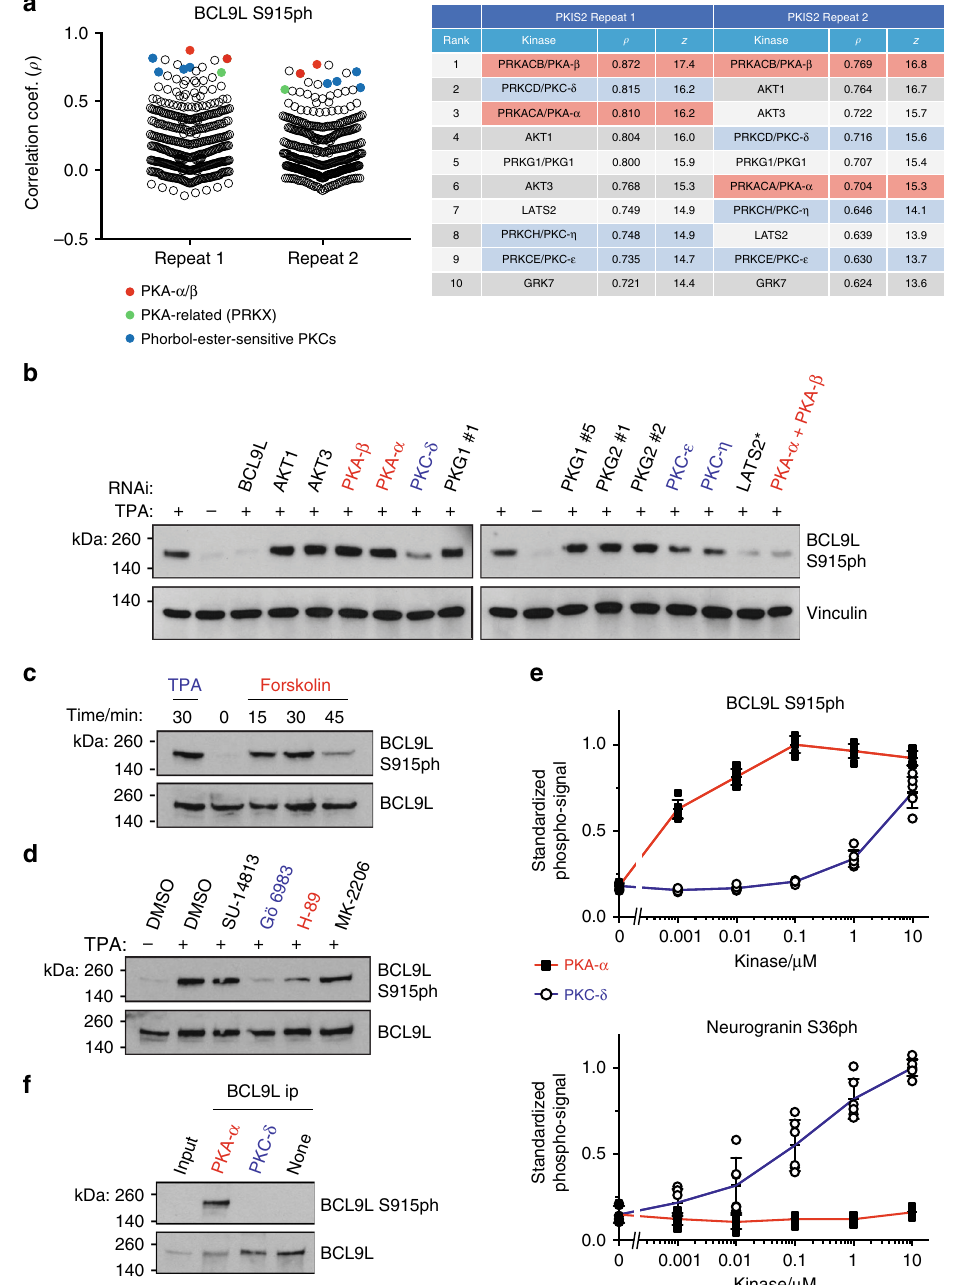
Fig. 6 Results of KiPIK screens for BCL9L S915ph and con fi rmatory experiments. a The stripcharts on the left show the Pearson correlation coef fi cients with each kinase in the PKIS2 DiscoverX pro fi ling dataset, for repeats 1 and 2. The table on the right shows the top 10 hits with corresponding correlation coef fi cients and z -scores. The overall top hit kinase (PKA) is shown in red, and the closely related kinase PRKX in green. Phorbol-ester-responsive PKC kinases are shown in blue. b RNAi of top hit kinases shows that co-depletion of PKA- α and - β diminishes TPA-induced BCL9L S915ph in HeLa cells, as does depletion of PKC isoforms. Loss of BCL9L S915ph was seen following PKA and PKC depletion in three separate experiments, but loss of BCL9L S915ph following LATS2 RNAi (*) was not a reproducible fi nding. c Forskolin increased BCL9L S915ph in HeLa cells (one of two separate experiments shown). d Inhibitors of PKA and PKC, but not of LATS and AKT kinases, decrease BCL9L S915ph in HeLa cells. Similar results were obtained in a second experiment. e Recombinant PKA- α (red line, black squares), but not PKC- δ (blue line, open circles), ef fi ciently phosphorylates BCL9L(908 – 922) peptides in vitro. In contrast, PKC- δ (but not PKA- α ) phosphorylates its known substrate Neurogranin(28 – 43). Phosphorylation was detected using antibodies to BCL9L S915ph and Neurogranin S36ph. Error bars show means ± SD ( n = 6 from two separate experiments). f BCL9L immunoprecipitated from HeLa cells is phosphorylated in vitro by recombinant PKA- α , but not PKC- δ . The experiment was done twice with similar results. Source data are provided as a Source Data fi